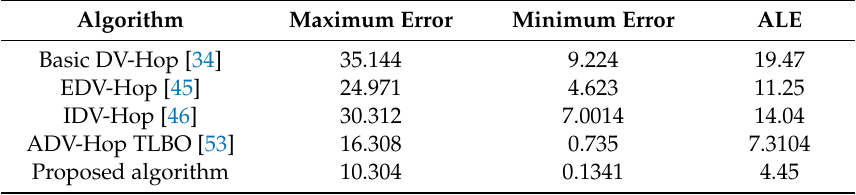
Table 5. Minimum, maximum and average localization error (ALE) comparison of algorithms (DOI = 0). DV-Hop, evolutionary DV-Hop (EDV-Hop), improved DV-Hop (IDV-Hop), and advanced DV-Hop with teaching learning based optimization (ADV-Hop